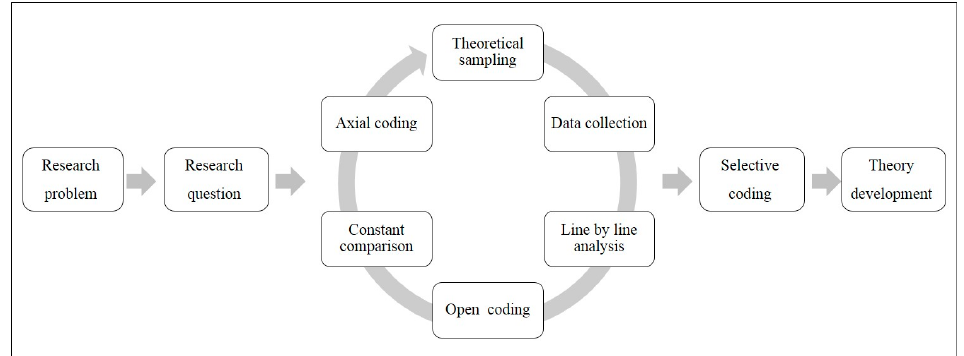
Figure 1. Grounded Theory Flow Chart.